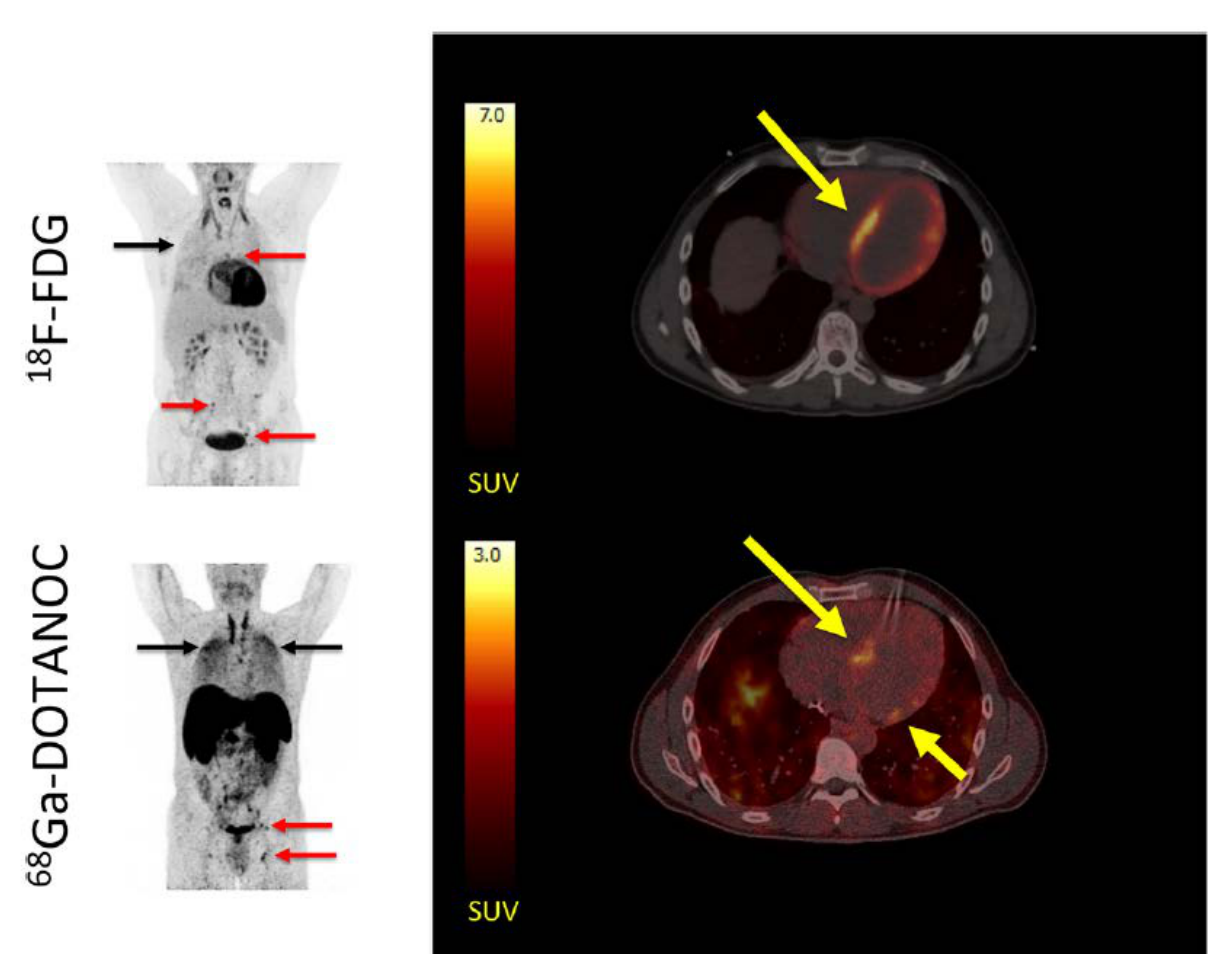
Figure 4. MIPs (left) showing multiple 18 F-FDG and 68 Ga-DOTANOC avid lymph nodes (red arrows) and lung tissue (black arrows) in a patient with both cardiac and systemic sarcoidosis. Transaxial slices of the heart (right) showed a focal on diffuse pattern of 18 F-FDG uptake (top right), which was rated as inconclusive by all reviewers, compared to all reviewers rating the 68 Ga-DOTANOC uptake (bottom right) as pathologic in the septum. Reprinted from ref. [65].